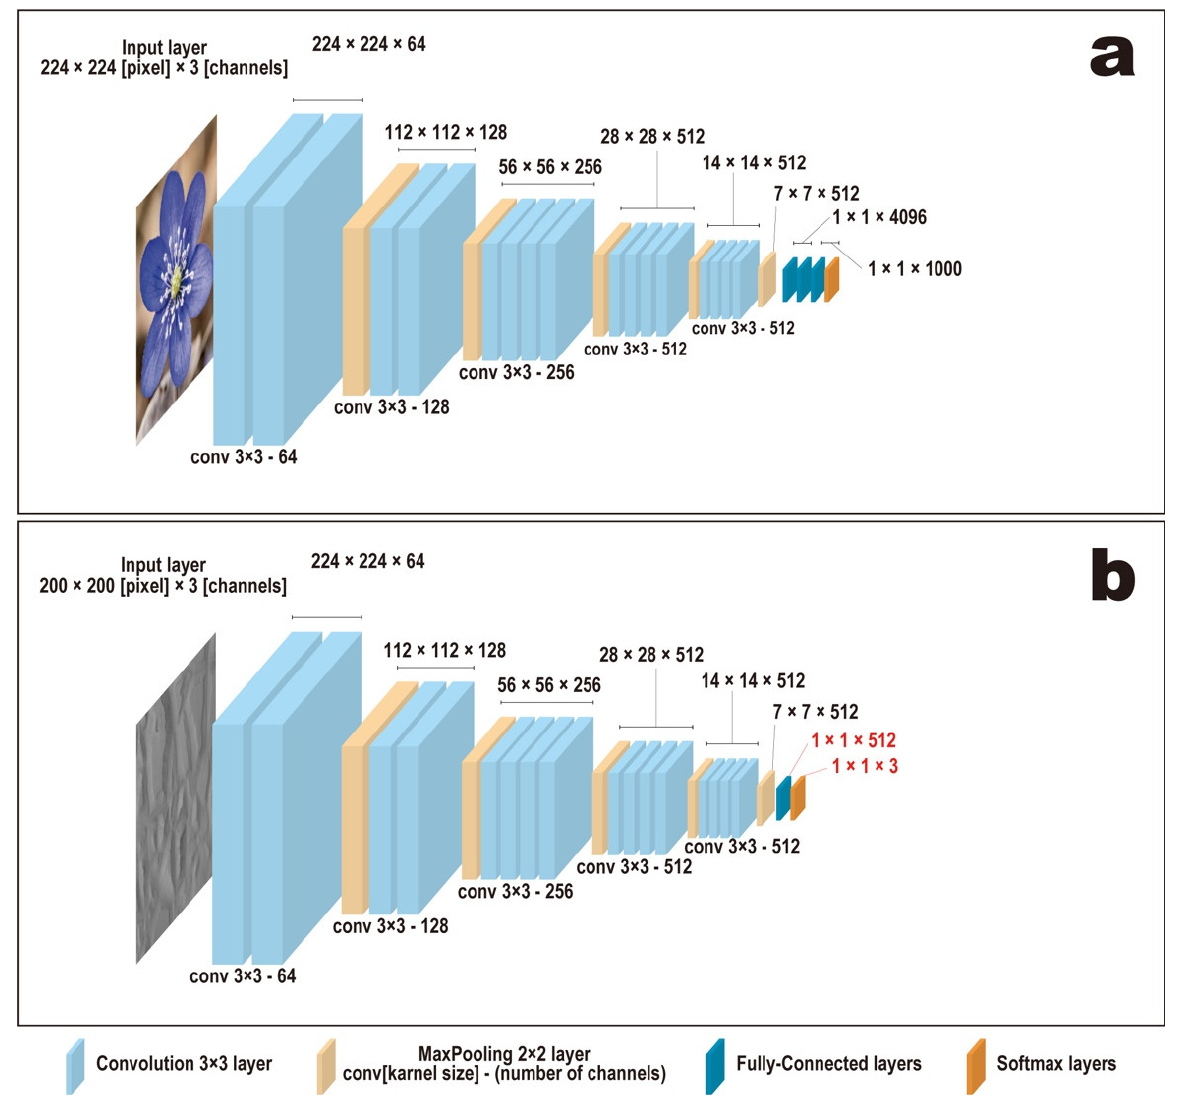
Figure 4. Architecture of ( a ) the pre-trained VGG19 network and ( b ) our revised classifier. There are 19 weight layers (16 convolutional layers and 3 fully connected layers), 5 pooling layers, and 1 softmax layer in the pre-trained VGG19 network. We replaced the fully connected layers and the softmax layer in our classifiers (see the text for details).